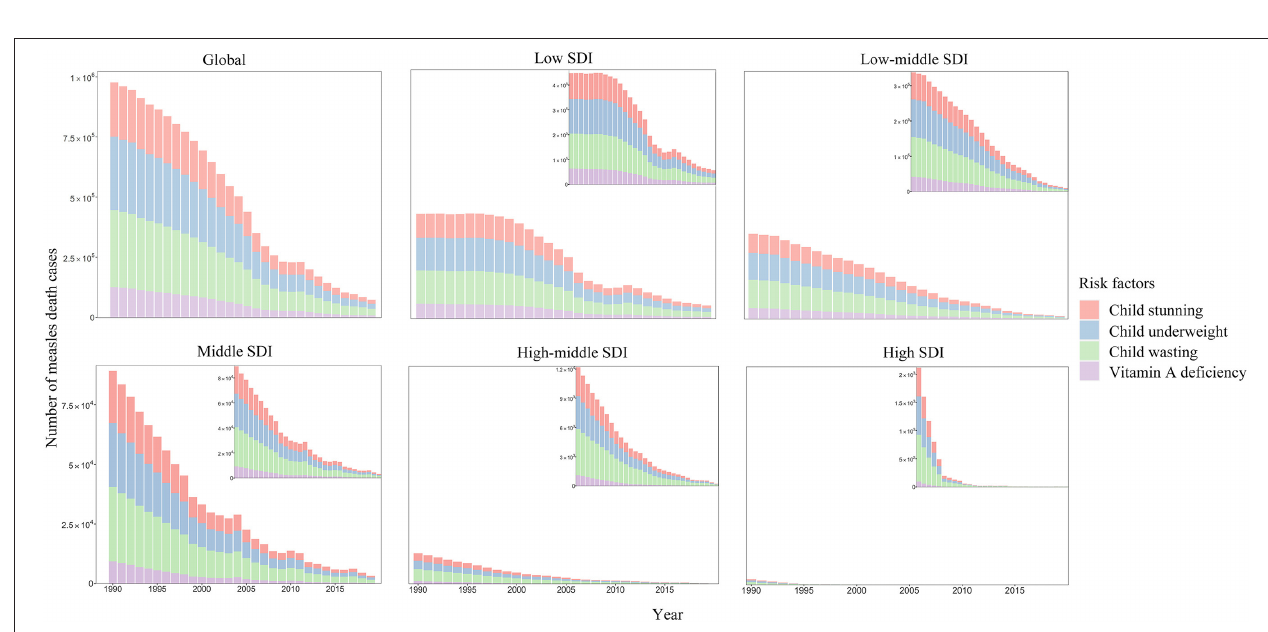
FIGURE 5 | The correlation between measles-containing vaccine coverage and SDI in 2019 at national level. (A) The correlation between MCV1 coverage rate and SDI in 2019 at national level. (B) The correlation between MCV2 coverage rate and SDI in 2019 at national level. MCV1, measles-containing vaccine, dose 1; MCV2, measles-containing vaccine, dose 2; SDI, socio-demographic index.